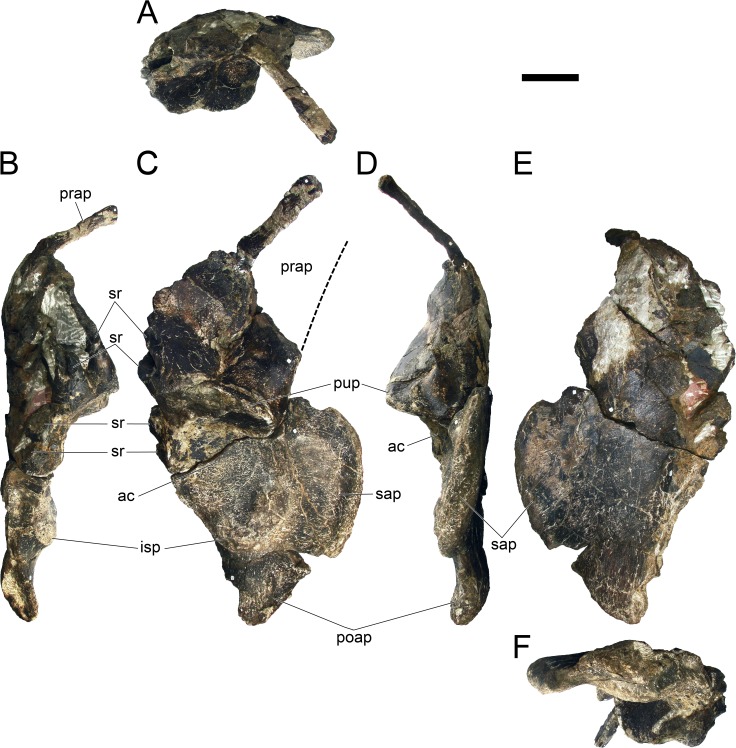
Left ilium and sacral ribs of Miragaia longicollum MG 4863.A, anterior, B, medial, C, ventral, D, lateral, E, dorsal, and F, posterior view. Ac, acetabulum, isp, ischial peduncle, poap, postacetabular process, prap, preacetabular process, pup, pubic peduncle, sap, supracetabular process, sr, sacral rib. Scale bar equal to 10 cm.